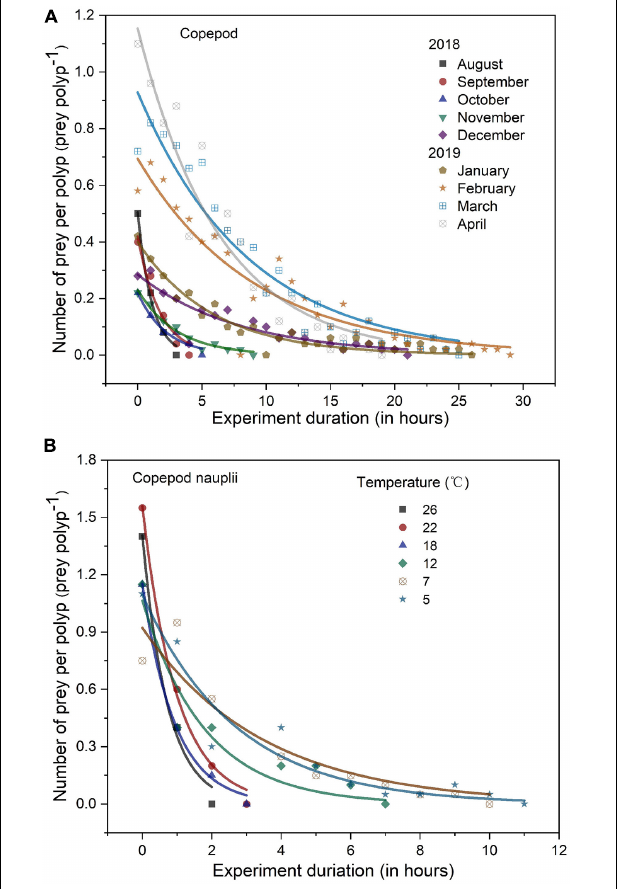
FIGURE 8 | Digestion processes of copepods (A) and copepod nauplii (B) in the gut cavity of A. coerulea polyp in situ experiment and laboratory experiment, respectively. Number of prey found in the gut of polyps at different points of the experiment expressed as prey polyp − 1 , and the curves of different colors were the results of exponential fitting. Time 0 means the initial